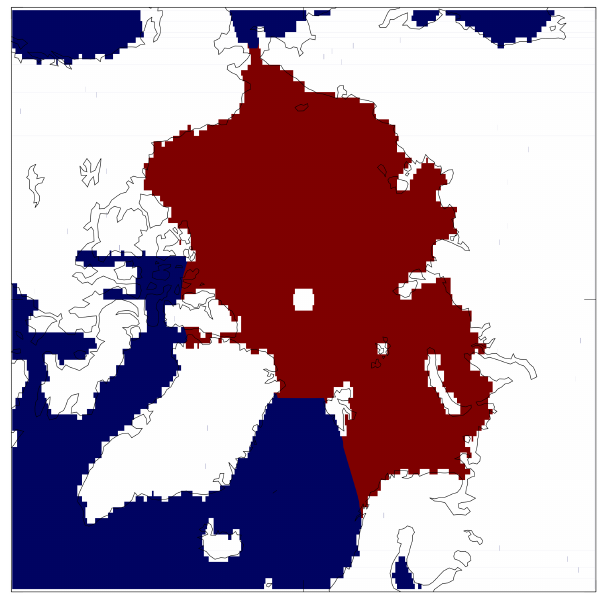
HadGEM2-ES this is formed by masking out all data south of 65 ◦ N for all latitudes and then the area bounded by 65 to 78 ◦ N and 90 ◦ W to 15 ◦